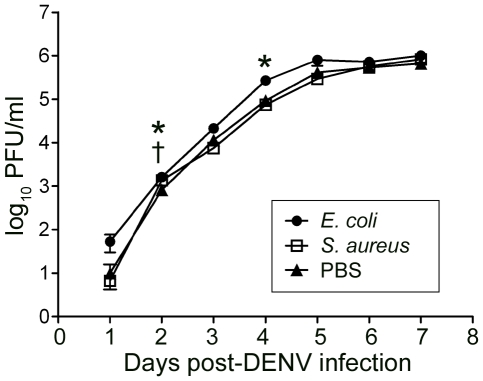
Effect of pre-immune stimulation on DENV titers in the cell line.Aag2 cells were pre-immune stimulated by the addition of heat-killed E. coli and S. aureus 24 h prior to DENV infection. The graph shows log10 DENV titers over 7 days as determined by plaque assay for cells pre-stimulated with heat-killed E. coli or S. aureus, or mock-stimulated with PBS. † represents p<0.05 in a Student's t-test comparing DENV titers in S. aureus- and mock-stimulated cells; * represents p<0.05 in a Student's t-test comparing DENV titers in E. coli- and mock-stimulated cells. Error bars indicate the standard error of the mean.